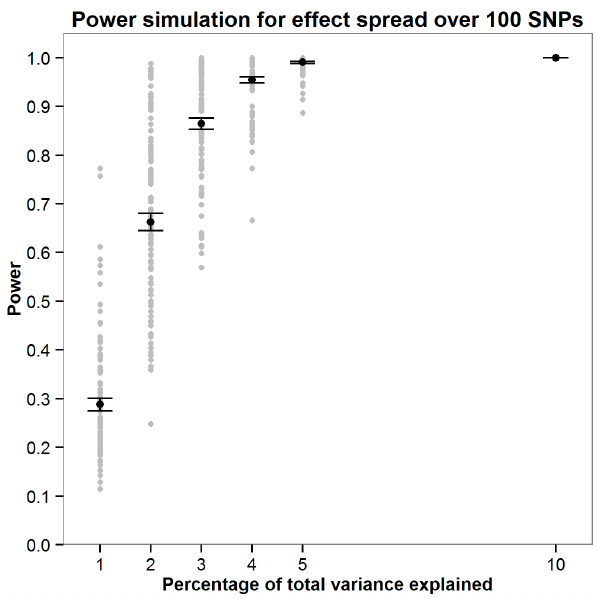
Figure 4. Simulations exploring how power fuctuates as a function of total variance explained when the effect is spread over 300 SNPs. For each effect size (1,2,3,4,5 or 10% of the total variance) 100 simulations were carried out. The mean power from these 100 simulations is shown in red with error bars depicting 6 1 standard error.